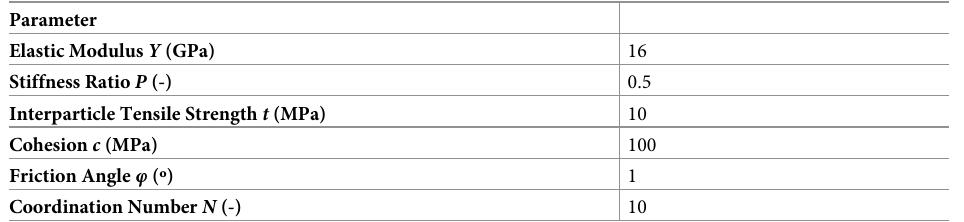
Table 2. Microparameters of the calibrated DEM model.